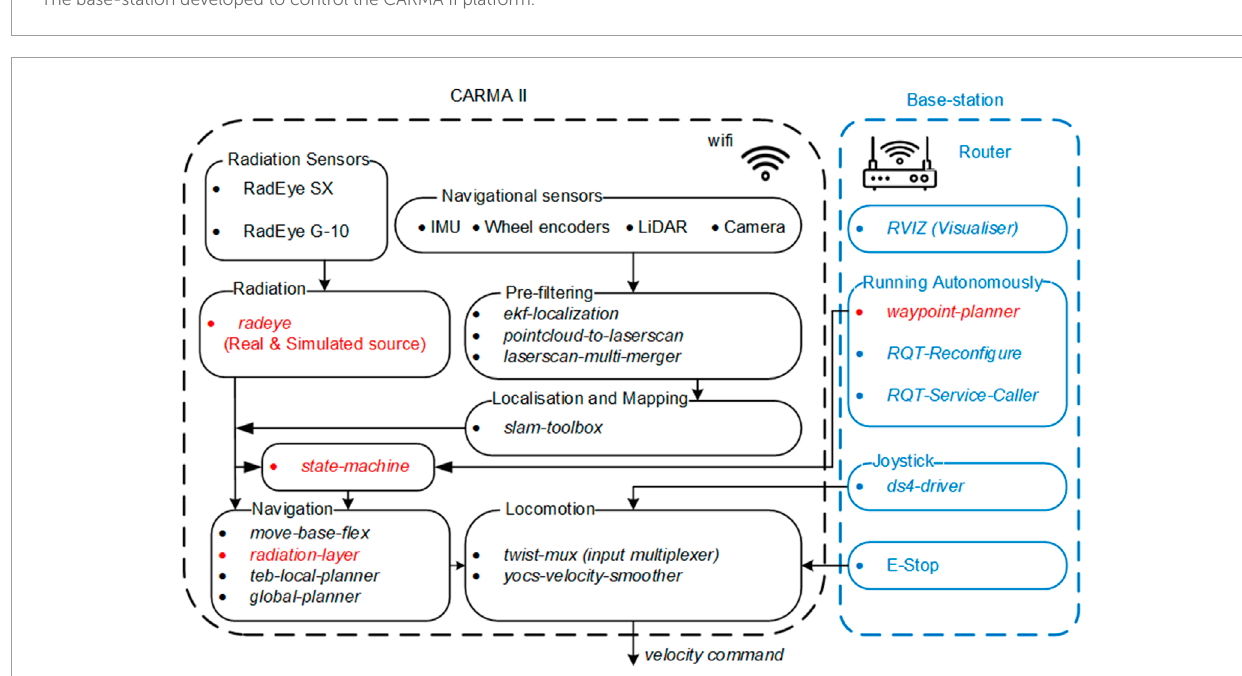
FIGURE 3 The ROS packages used on CARMA II and the base-station (packages in red text were developed for CARMA II).